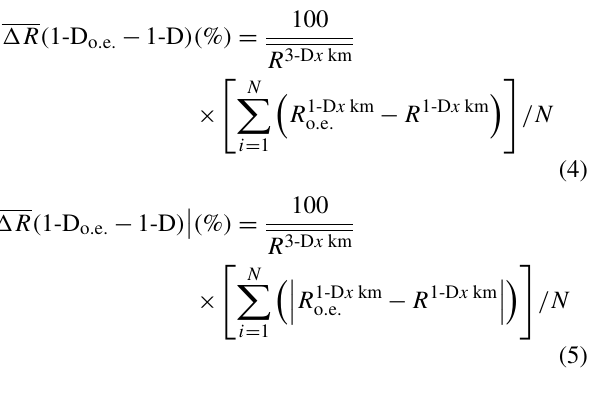
tively, and are also represented in Fig. 13a and b,